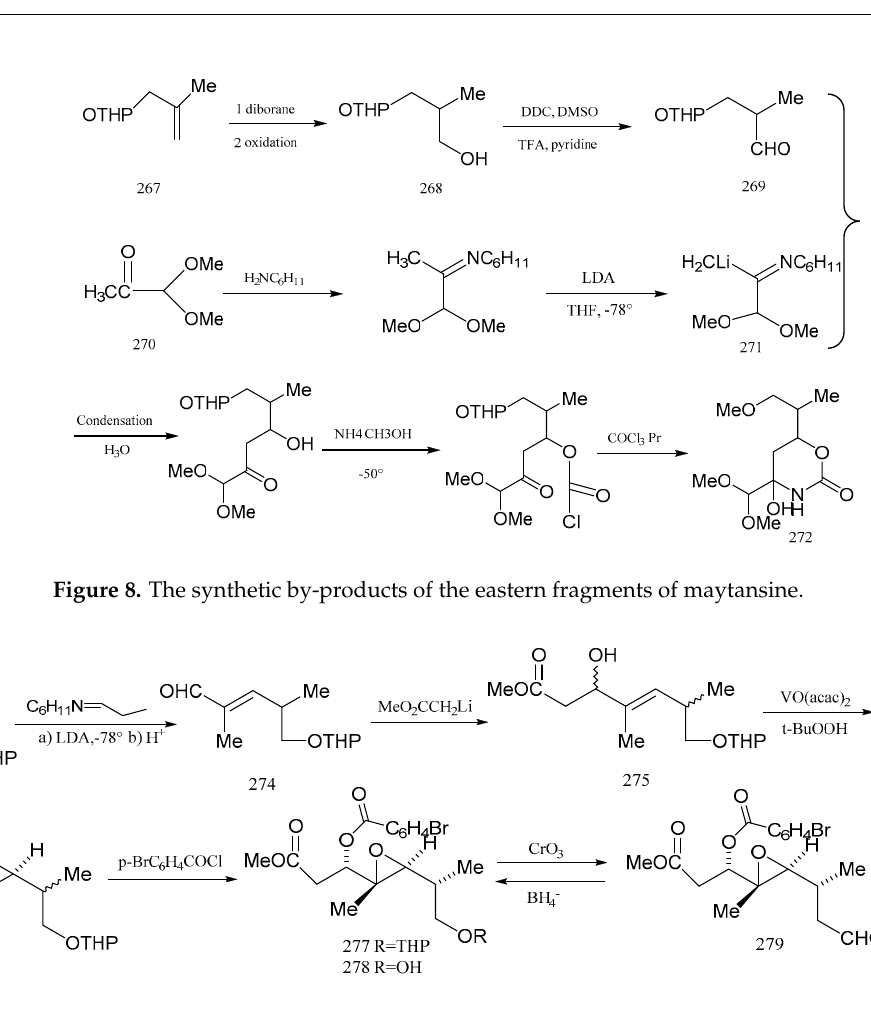
Figure 10. Some alternative synthetic by-products of the northern fragments of maytansine using two Wittig aldol con- densation reactions. Meyers et al. [94] also synthesized the “western” zone products of maytansine, which contains an unusual aromatic substitution array. Methyl vanillate was used as the raw